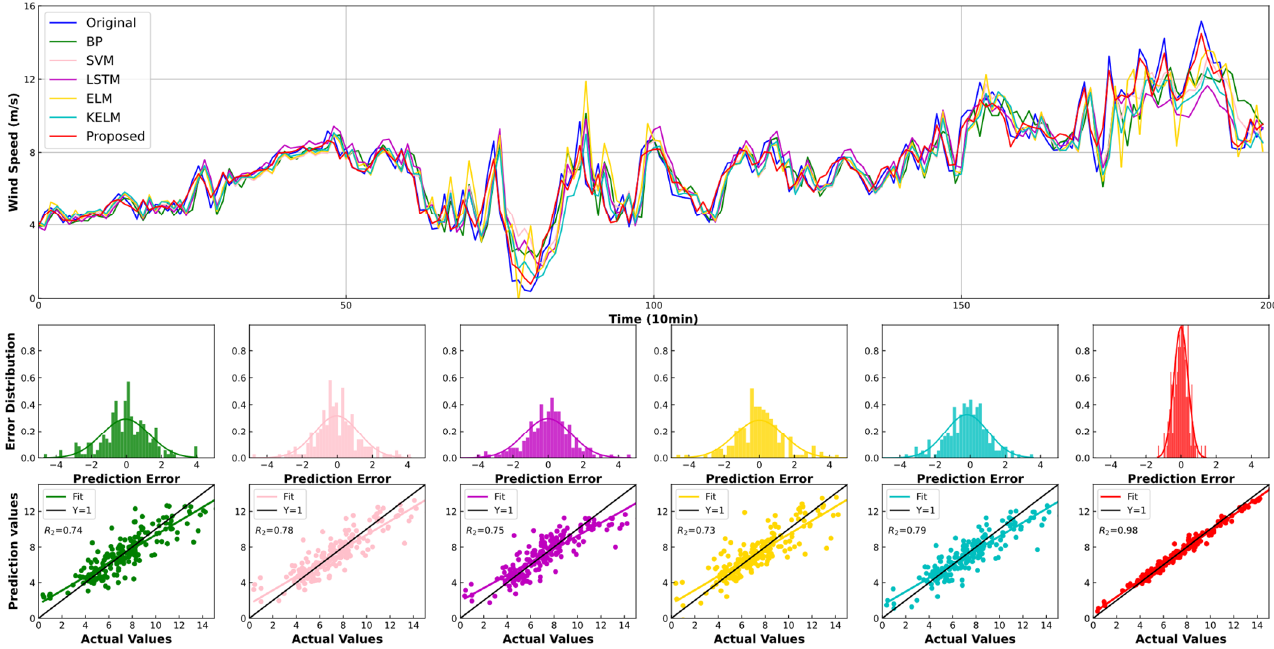
Figure 2. The results of each prediction model in one-step prediction in SH Apr.